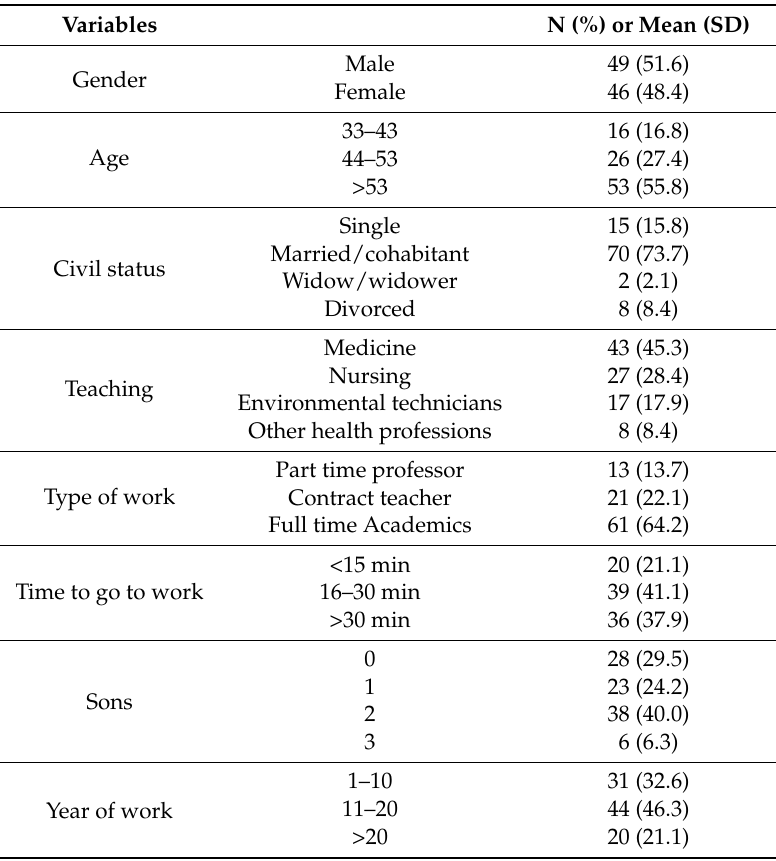
Table 1. Characteristic of the whole